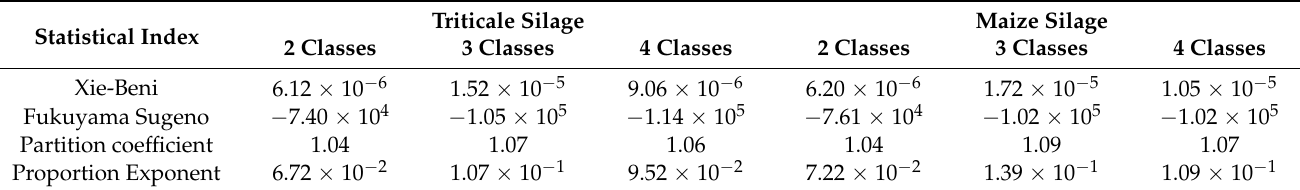
Table 3. The statistical indices values showing the optimum number of clusters for site